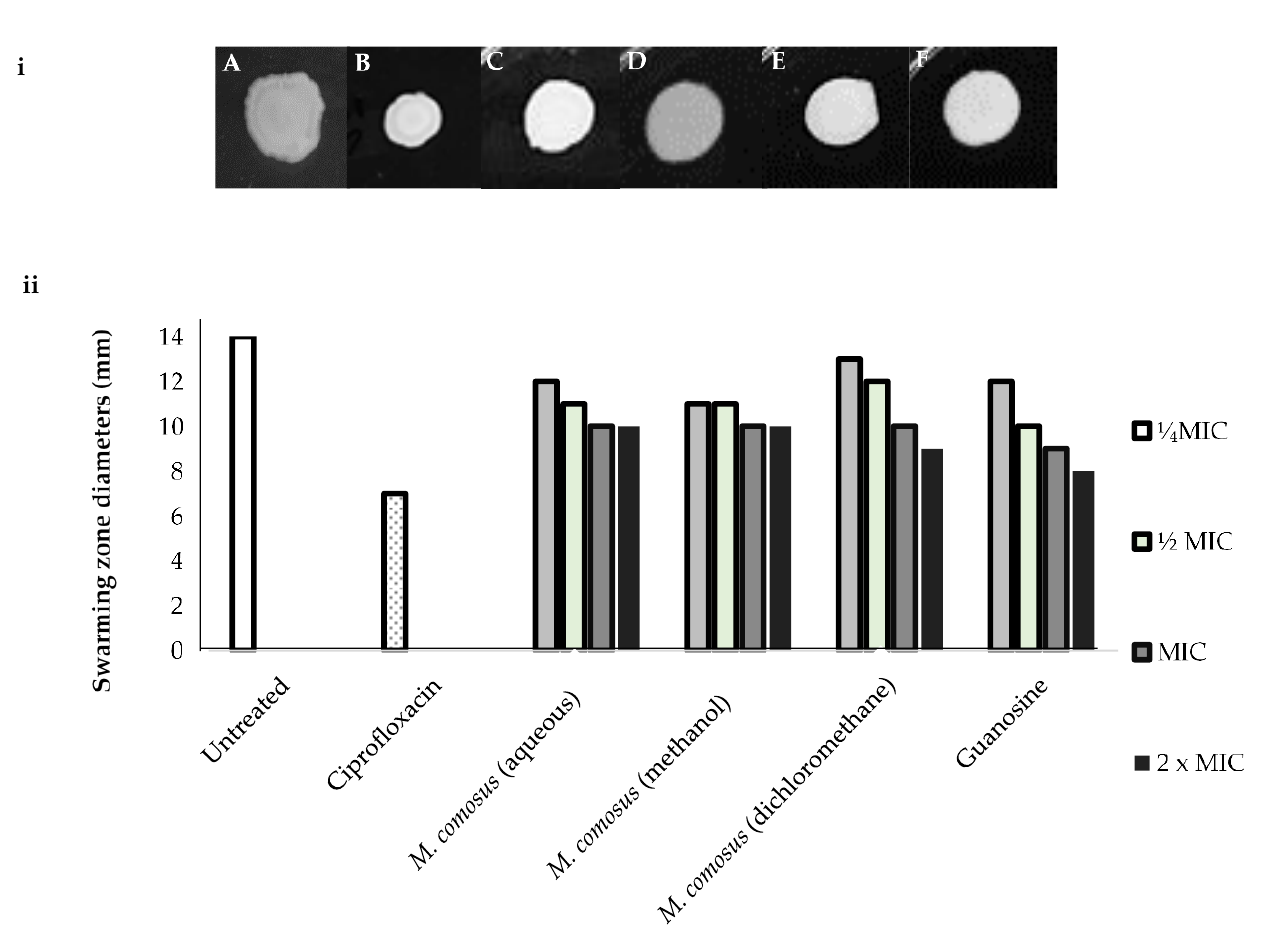
Figure 7. ( i ) ( A ) Negative control (untreated cells), ( B ) ciprofloxacin, ( C ) M. comosus (aqueous), ( D ) M. comosus (methanol), ( E ) M. comosus (dichloromethane) extracts and ( F ) guanosine are representative images of P. aeruginosa swarming motility treated with M. comosus (aqueous, methanol and dichloromethane) extracts and guanosine at 1.56 and 0.062 mg/mL (2 x MIC) concentration, respectively, and ( ii ) bar graph showing M. comosus extracts and guanosine at sub-MIC concentrations. Mean values are of triplicate zone diameters.